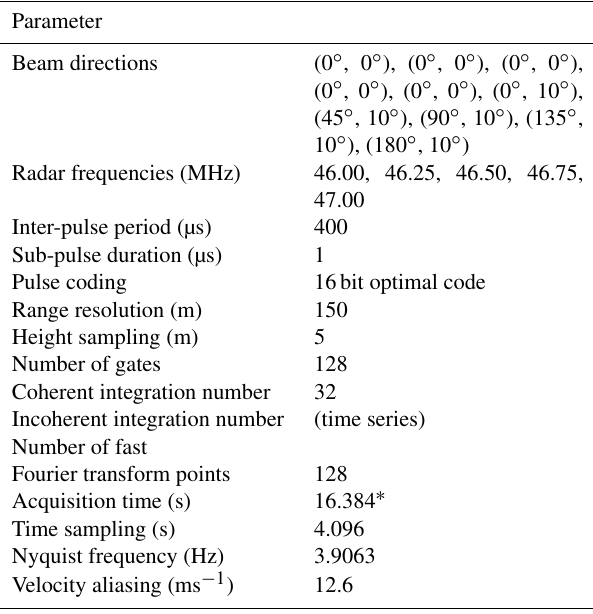
Table 1. MU Radar parameters used during the ShUREX